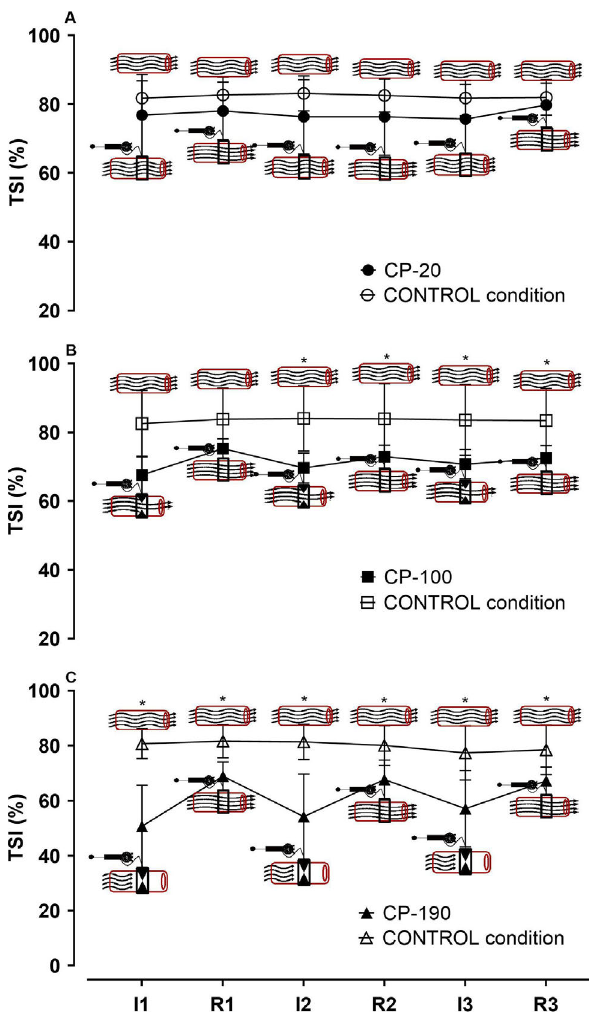
Figure 4 - (A) Graphic of TSI comparing control condition with the maneuver. TSI, local muscle oxygenation; CP-20, cuff-pressures of 20 mmHg; control condition, no cuff. (B) Graphic of TSI comparing control condition with the maneuver. TSI, tissue saturation index; CP-100. cuff- pressures of 100 mmHg; control condition, no cuff. (C) Graphic of TSI comparing control condition with the maneuver. TSI, local muscle oxy- genation; CP-190. cuff-pressures of 190 mmHg; control condition, no cuff. Difference in comparison between the control condition and man- euver represent by